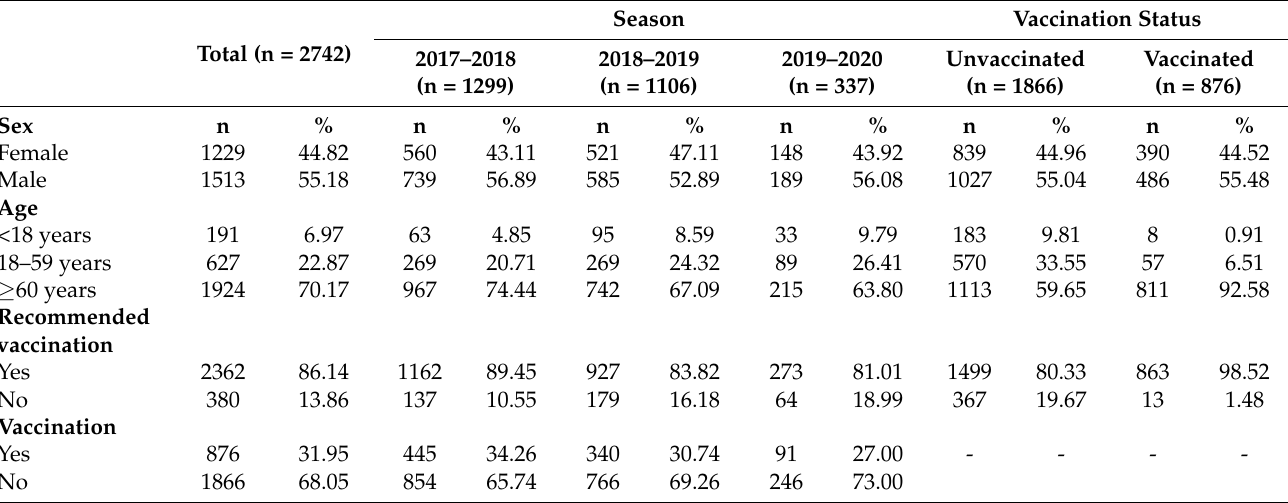
Table 2. Demographic characteristics of cases by season and vaccination status.